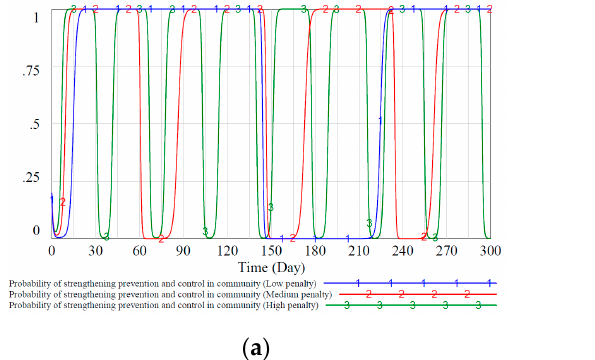
Figure 7. Proportion of the evolutionary stable equilibrium strategy of the community under the static and dynamic reward and punishment mechanisms. ( a ): probability of strengthening prevention and control in community in different penalty intensities under the static mechanism. ( b ): probability of strengthening prevention and control in community in different penalty intensities under the dynamic mechanism.